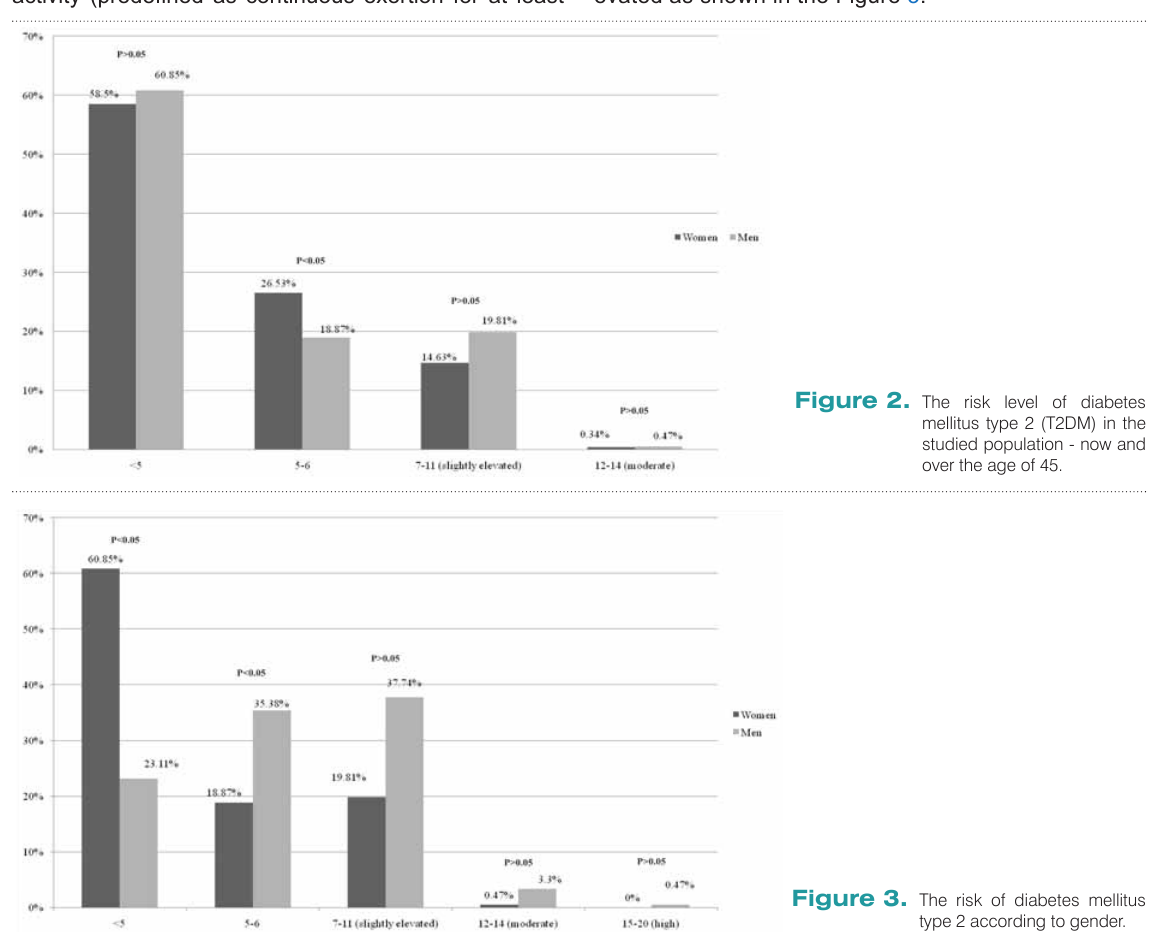
Figure 3. The risk of diabetes mellitus type 2 according to